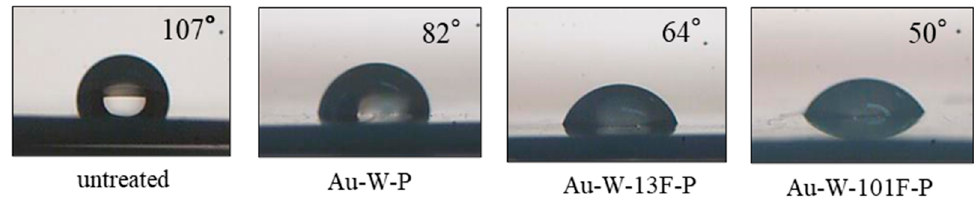
Figure 4. Contact angles of various PTFE samples using water.